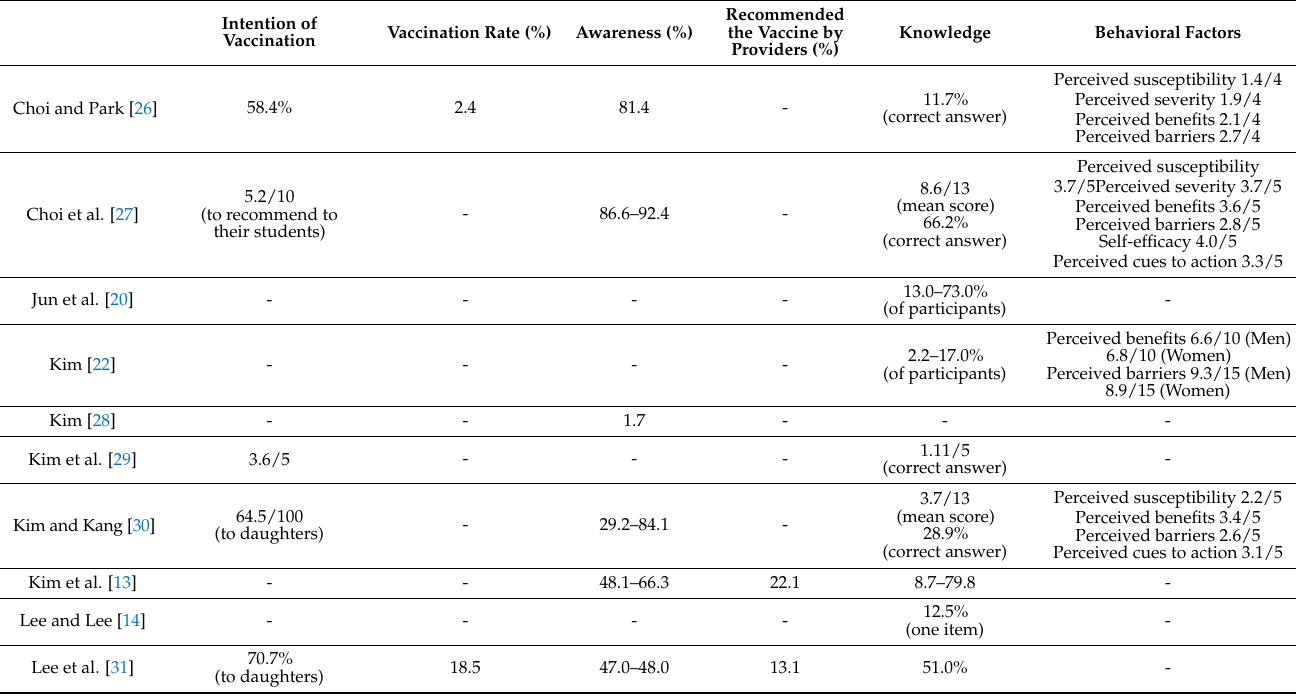
Table 2. Descriptive characteristics of the HPV-related